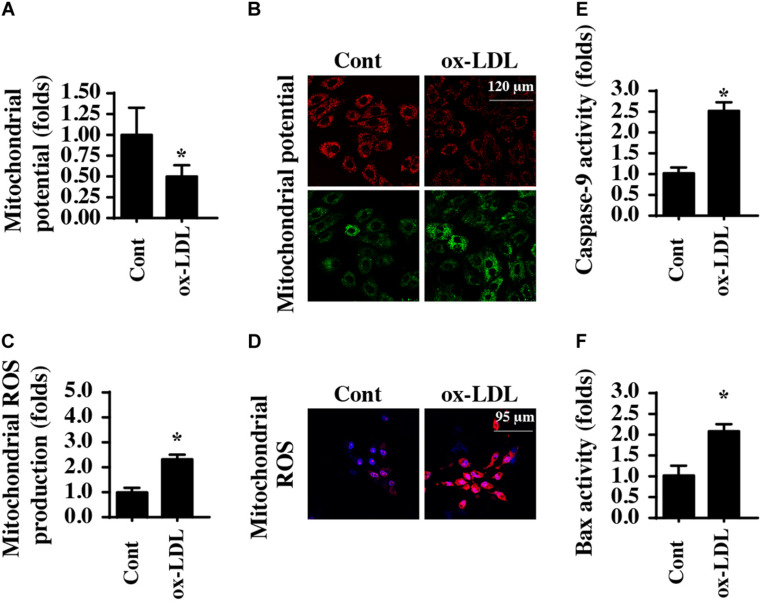
Ox-LDL promotes endothelial cell death through the activation of mitochondria-dependent apoptosis. (A,B) A JC-1 probe was used to observe the mitochondrial membrane potential in endothelial cells after ox-LDL exposure. (C,D) Mitochondrial ROS production was measured through immunofluorescence in ox-LDL-treated endothelial cells. (E,F) An ELISA was used to observe the changes in concentration of capsase-9 and Bax. *p < 0.05.